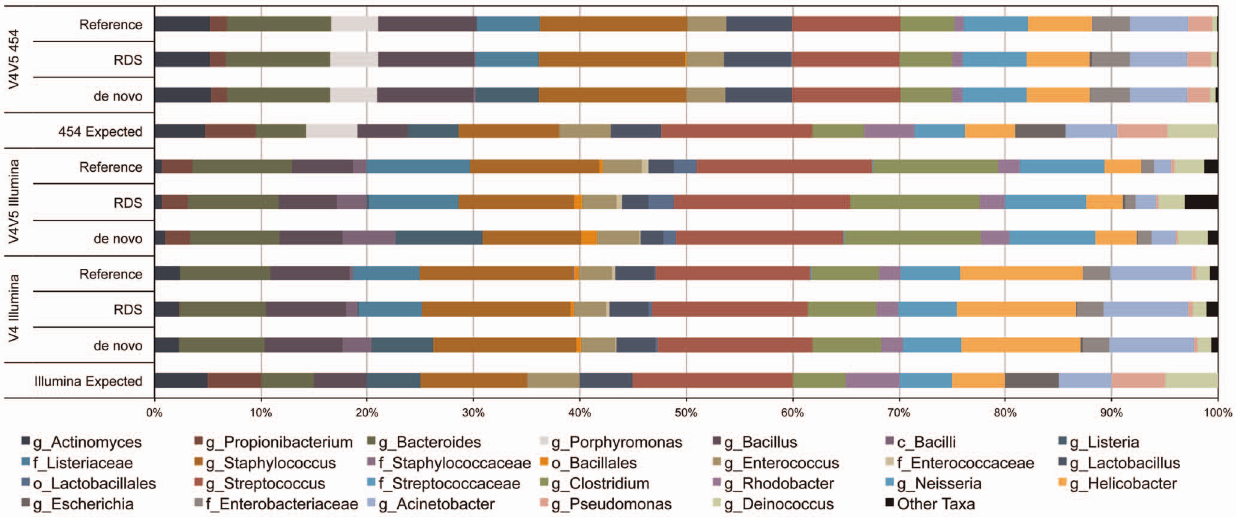
Figure 4. Effect of processing method on the taxonomic composition of the mock community datasets. Plot comparing the taxonomic composition of the mock community sample for the three different library types sequenced when processed three different ways. The replicate V4 and V4-V5 Illumina datasets were combined into one representative dataset for each library type. All taxonomic assignments were made using the RDP Classifier after retraining with the 2013-08 Greengenes reference. Taxonomic ranks are noted by letters preceding the taxon name as follows: genus – g, family – f, order – o.